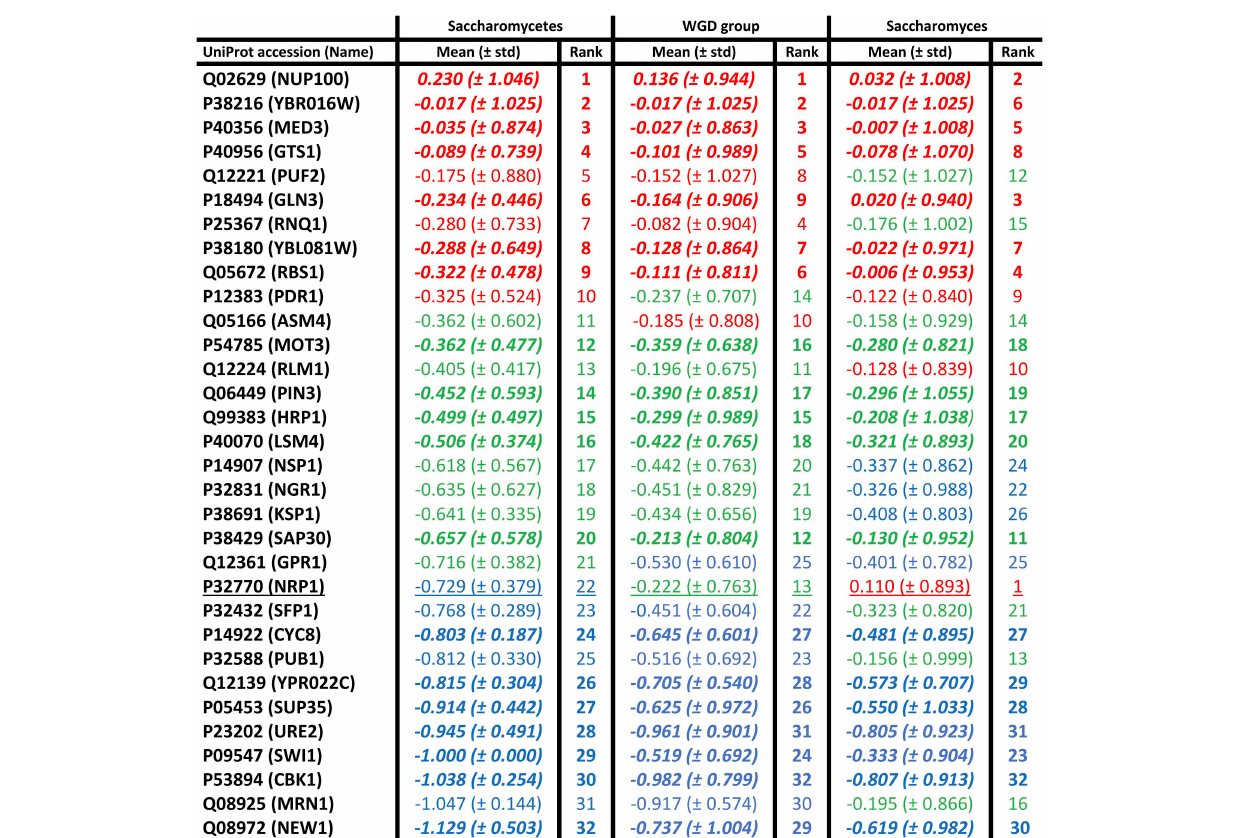
FIGURE 2 | Individual mean conservation values for prion-forming domains. These are tabulated for each domain, with the top, middle, and bottom thirds colour-coded red, green, and blue, but with the ordering of the first column maintained across the figure. The numerical ranking is also listed for each domain at each level. The domains that are conserved in the same thirds at all levels are in bold italic. There is only one domain that moves between all three thirds of the list (underlined). The standard deviations are in brackets.